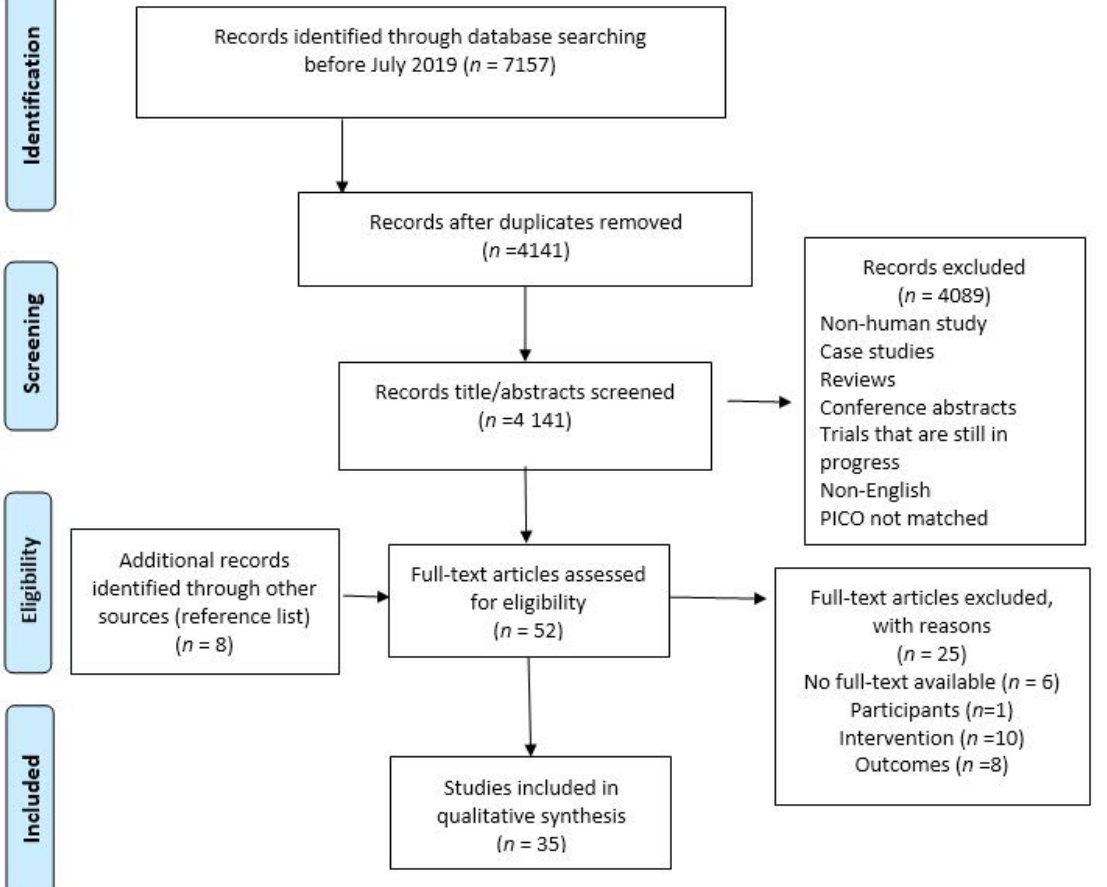
Figure 1. PRISMA flow chart diagram of study selection process. Note. Lab studies without human participants (participants), studies without texture-modified diets (TMDs) or thickened fluids (TFs) consumers (intervention) or study outcomes did not include nutrition measurement (outcomes) were